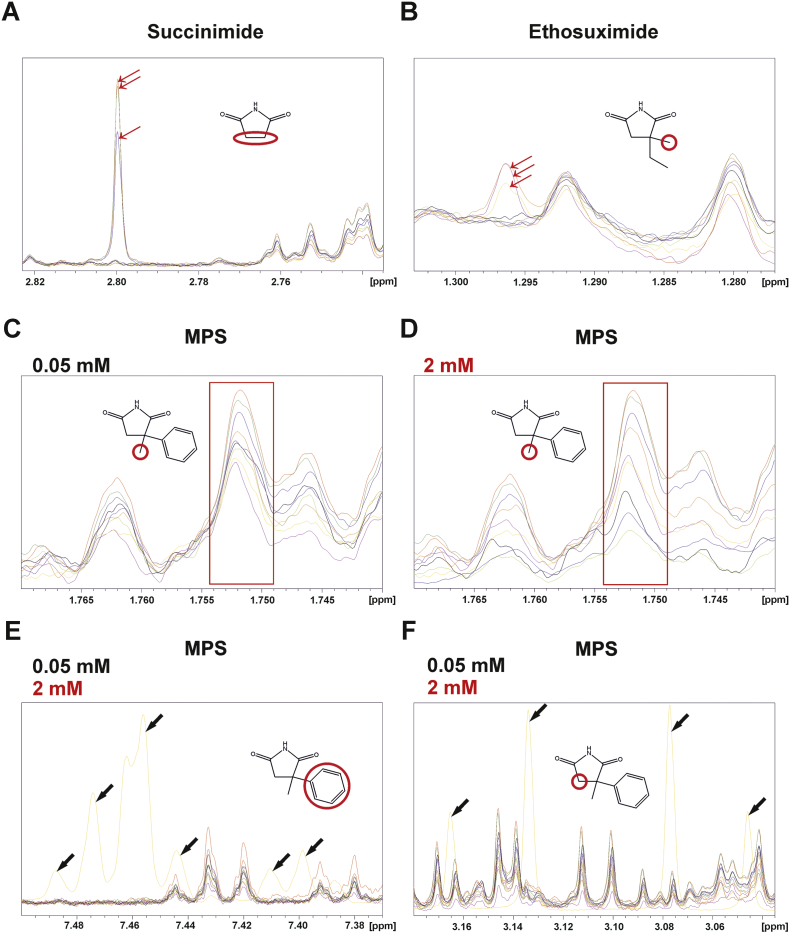
Determining compound bioaccumulation in TDP-43(A315T) worms model worms using 1H NMR. Overlay of spectra from lysates of chronically treated, age-synchronised day 1 adult TDP-43 expressing worms are shown, emphasising regions with compound-derived peaks of interest. (A) Succinimide (2.82–2.74 ppm) and (B) ethosuximide-derived peaks (1.30–1.28 ppm) were readily distinguishable in samples treated with an 8 mM external concentration of both compounds (red arrows). Peaks common to compound-treated and non-treated lysates arising from endogenous C. elegans metabolites are also shown alongside compound-derived peaks for comparison. Data shown are from nine 1H spectra from three treatment conditions with three biological replicates each. (For interpretation of the references to colour in this figure legend, the reader is referred to the web version of this article.)(C,D) The singlet peak with the highest intensity from MPS (red boxed region) was indistinguishable from endogenous metabolites in samples treated with either the optimal neuroprotective concentration of 0.05 mM (C) or the highest tolerable concentration of 2 mM (D). Due to the undetectability of the singlet peak, the presence of other compound-derived multiplet peaks in the aromatic (E) or –CH2 (F) region were analysed from spectra derived from treatment with both low and high concentrations. To facilitate peak identification from these multiplets, the reference spectrum of the pure compound was overlaid with those from treated worm lysates; reference peaks as shown in yellow and indicated with black arrows. These peaks were also not detectable from samples. Data shown is from nine 1H spectra from three treatment conditions with three biological replicates each.